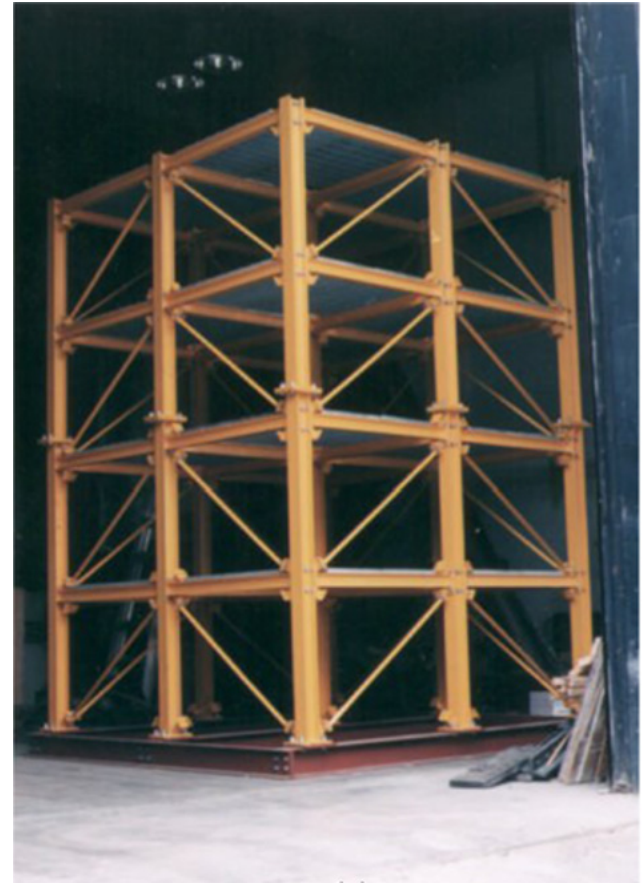
Figure 15. Four-story structure of ASCE benchmark .